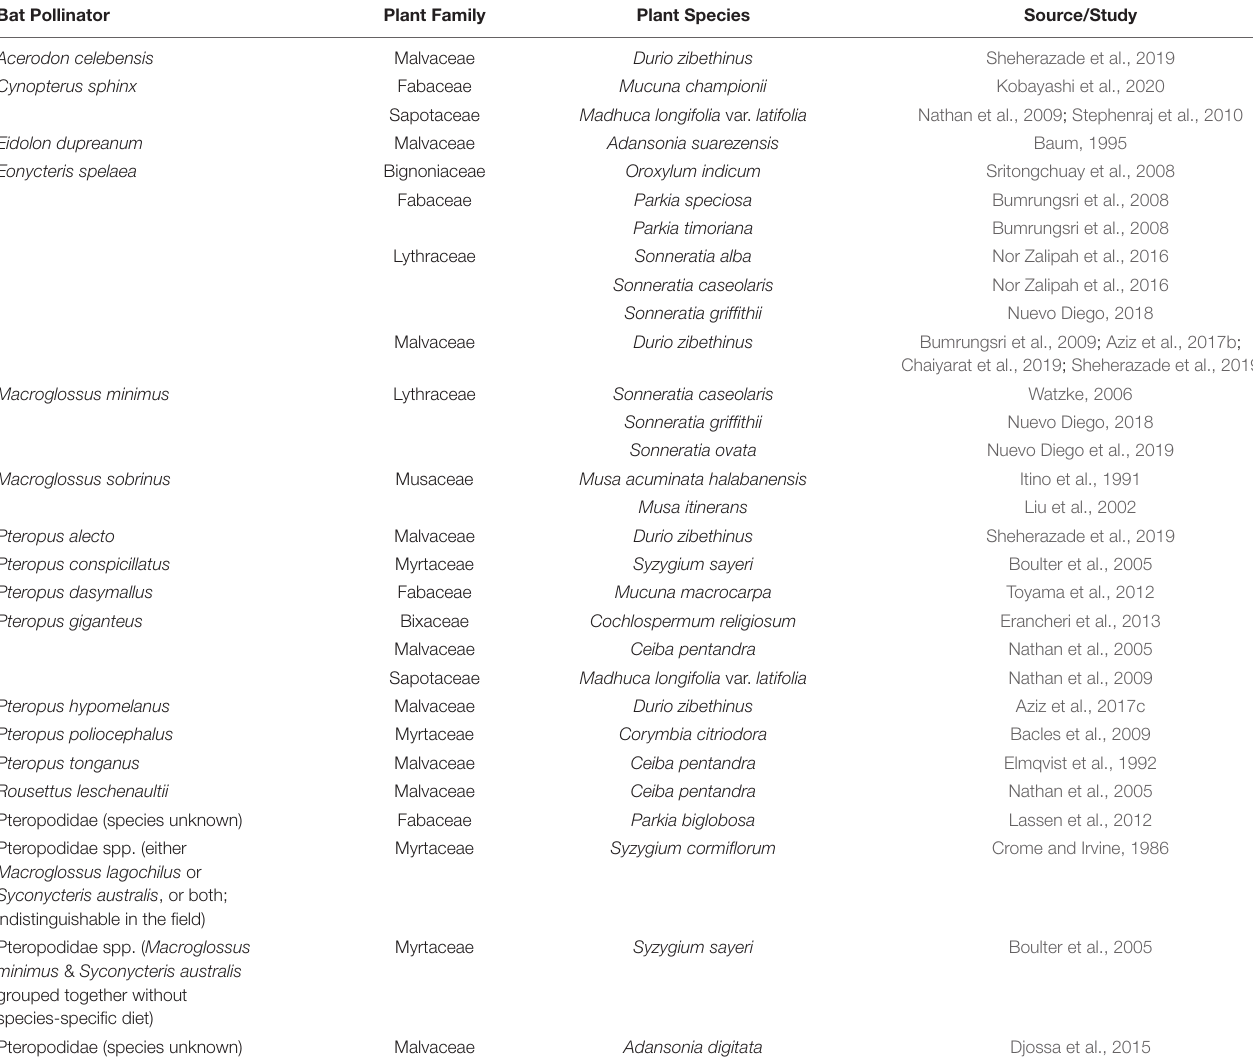
TABLE 3 | Confirmed pteropodid pollinators and their associated bat-pollinated plant